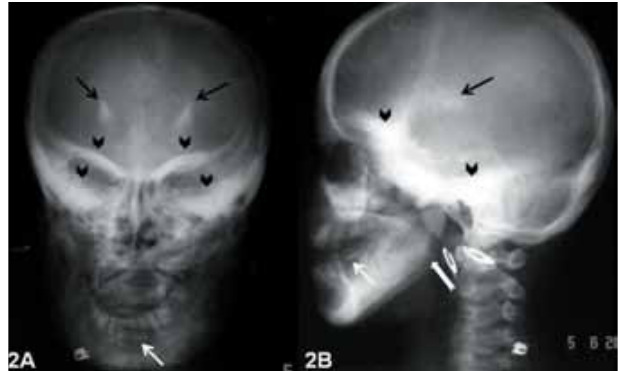
arrows).Fig. 2. AP X-ray of the skull (2A) and lateral (2B) view show a ghost-like appearance (‘alien look’) with cranial hyperostosis (black arrowheads). Focal bilateral symmetrical intracranial calcification is seen (black arrows). Thinned out and focally absent enamel with missing teeth and cavities are seen (thin white arrows) with broadened mandible (thick white